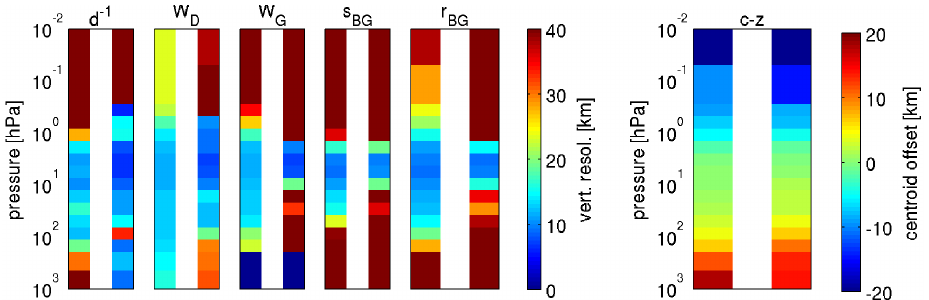
Figure 6. Median vertical resolution estimates (abbreviated as vert. resol.) and centroid offset of GOME-2 (2008) data retrieved by OPERA v1.26 (each left colour profile) and RAL v2.1 (each right colour profile). Note that the centroid offset plots and vertical resolution plots have different colour scales, although their absolute ranges are identical (40km). d − 1 , W D , W G , s BG , r BG , and c − z denote the data density reciprocal, direct and Gaussian FWHM, Backus–Gilbert spread around the nominal and centroid altitude, and centroid offset, respectively.